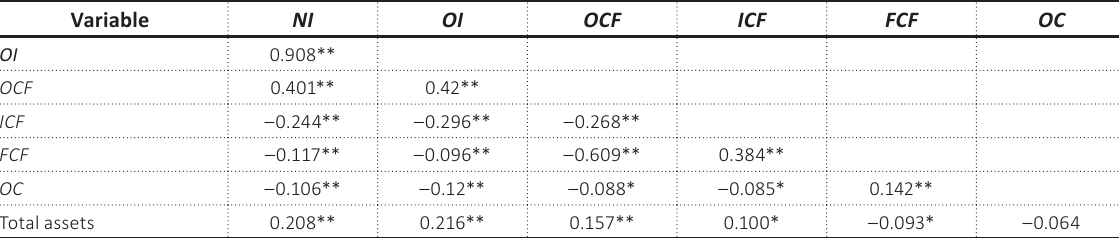
Table 2. Correlation